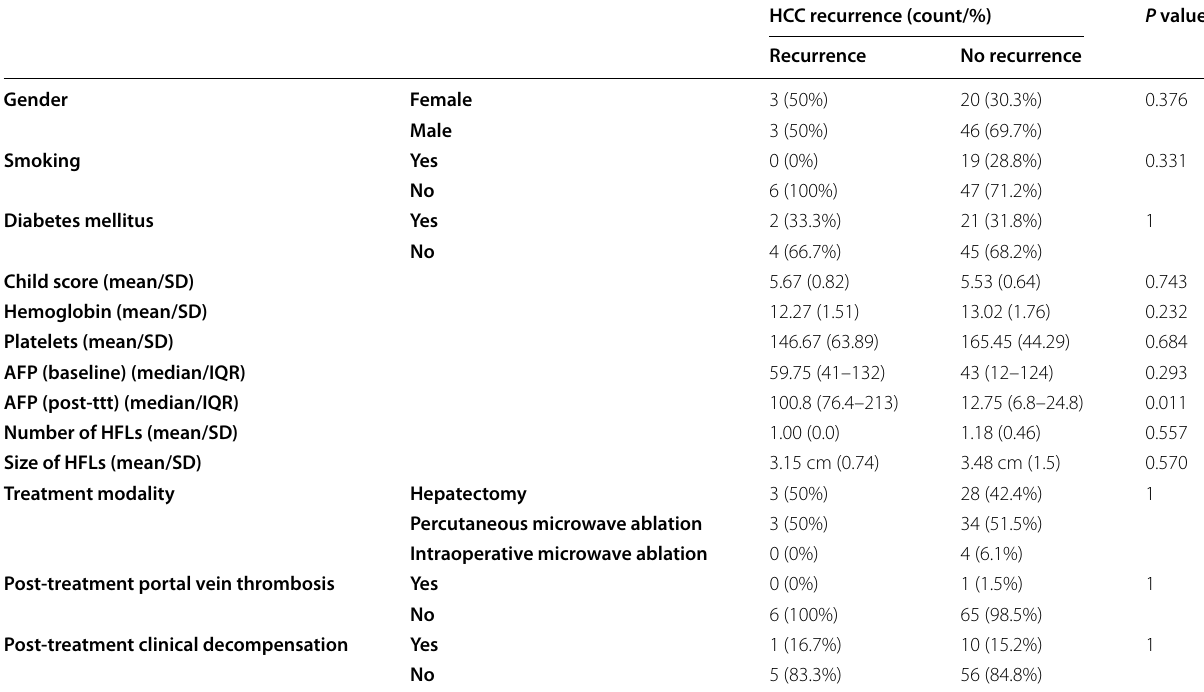
Table 3 Predictors of HCC